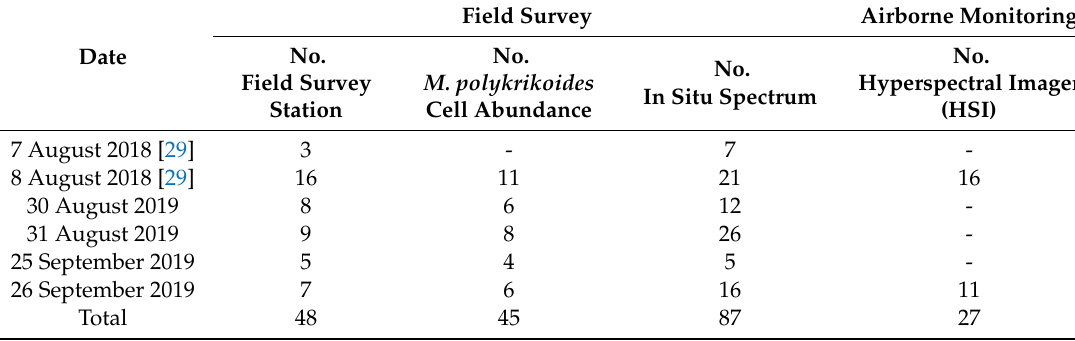
Table 1. The information of field surveys and airborne